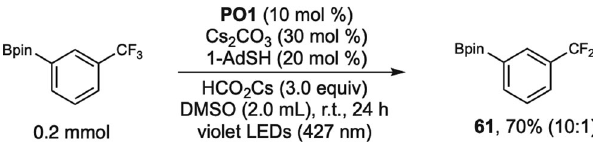
Fig. 8 Monoselective hydrode fl uorination of tri fl uoromethyl arene. Yield of isolated product. The ratio of monohydrode fl uorination and dihydrode fl uorination measured by 19 F-NMR is shown